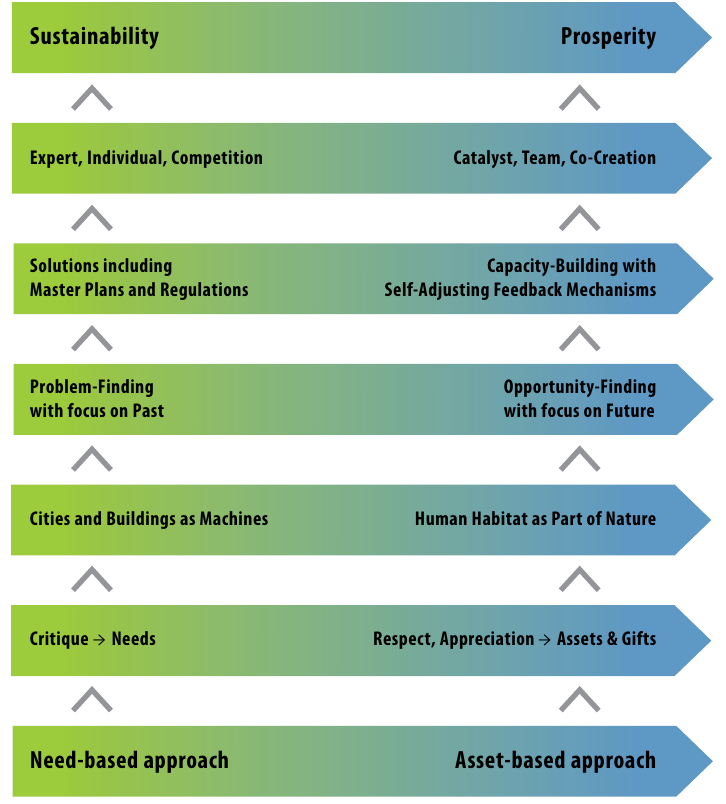
Fig. 9. The shift from sustainability to